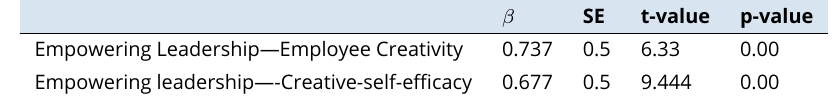
Table 4. Regression Analysis